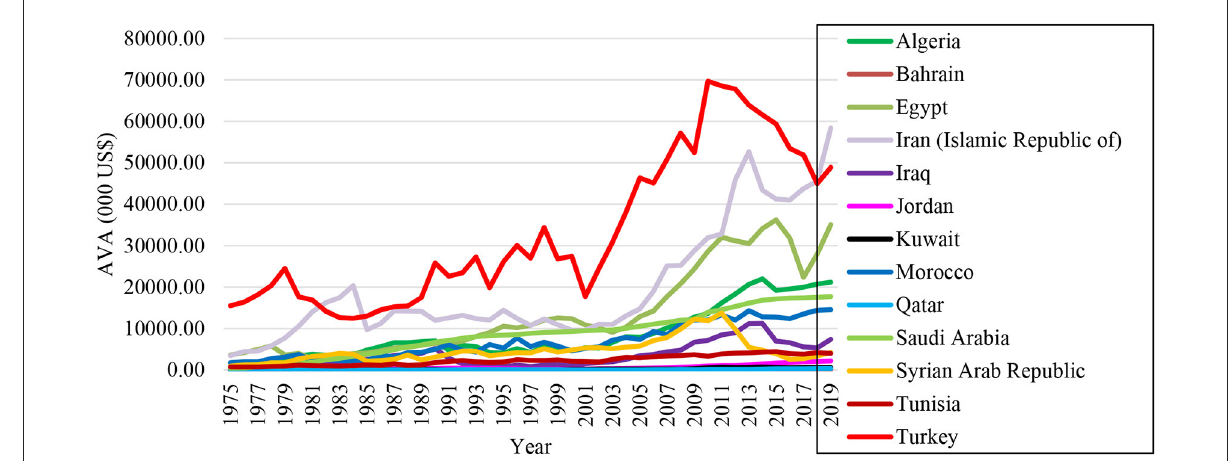
FIGURE1 AVA in the MENA